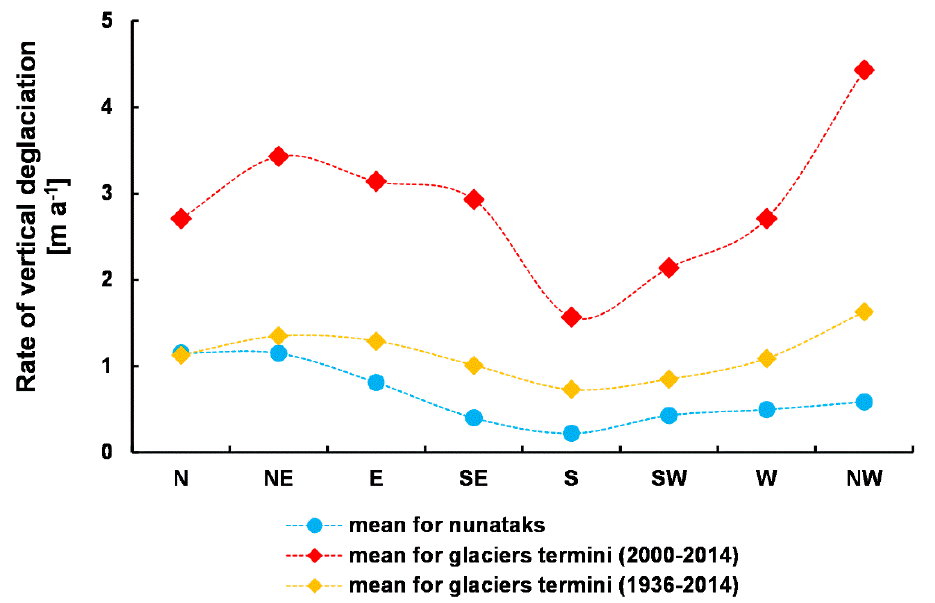
Figure 8. Average rate of relative decrease of the mean nunatak elevation in relation to the slope exposure for the 1985–2017 period, in comparison with the average rate of increase of the termini altitude of glaciers terminating on land (1936–2014 and 2000–2014 periods, based on data in Szafraniec